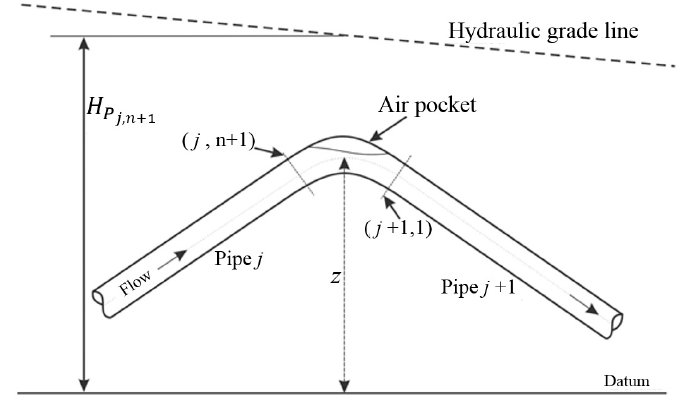
Figure 7. Notation for the air pocket.